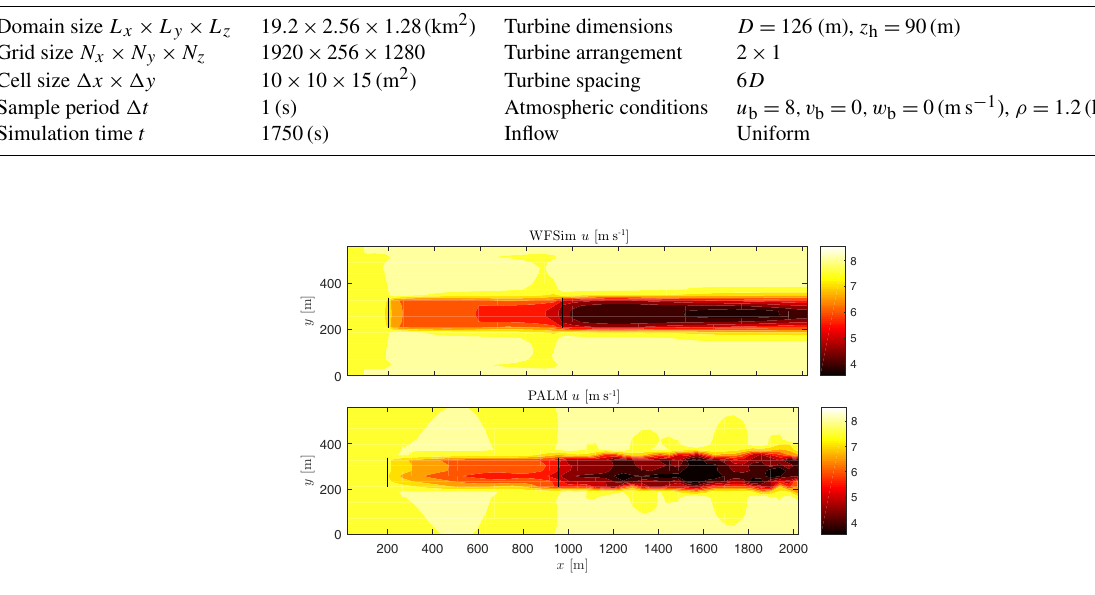
Figure B1. Flow field obtained with PALM (below) and WFSim at t = 750(s). The black lines indicate the turbines.